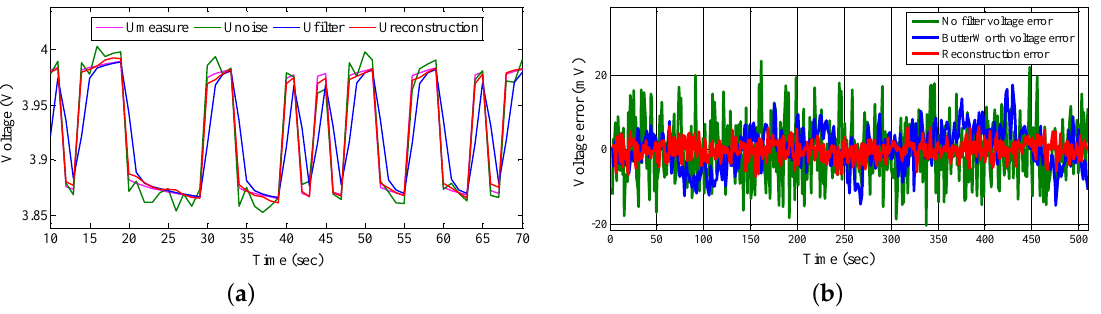
Figure 7. Comparison of the measured, noisy, filtered, and reconstructed voltages. ( a ) Comparison of different voltage waveforms. ( b ) Errors between different voltages and measured